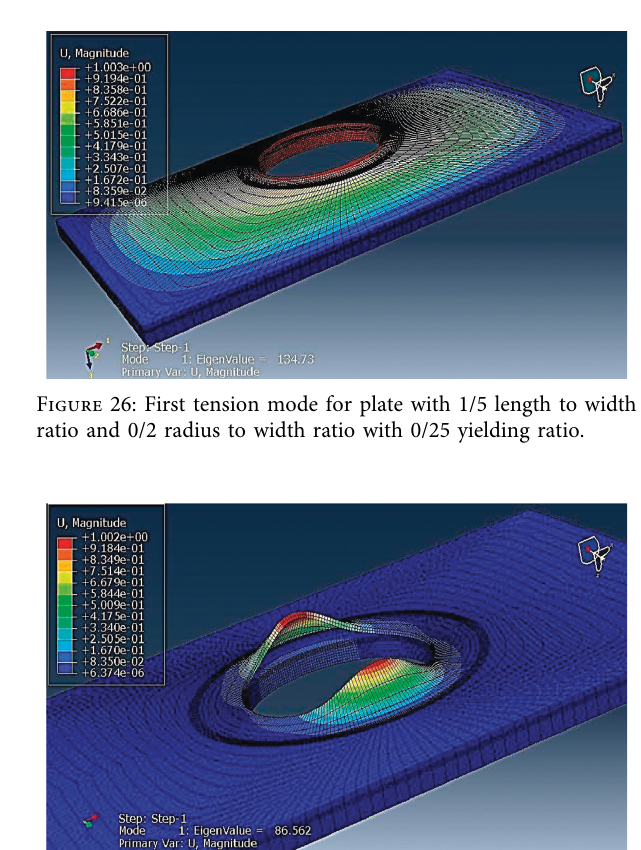
Figure 27: First tension mode for plate with 1/5 length to width ratio and 0/2 radius to width ratio with 0/5 yielding